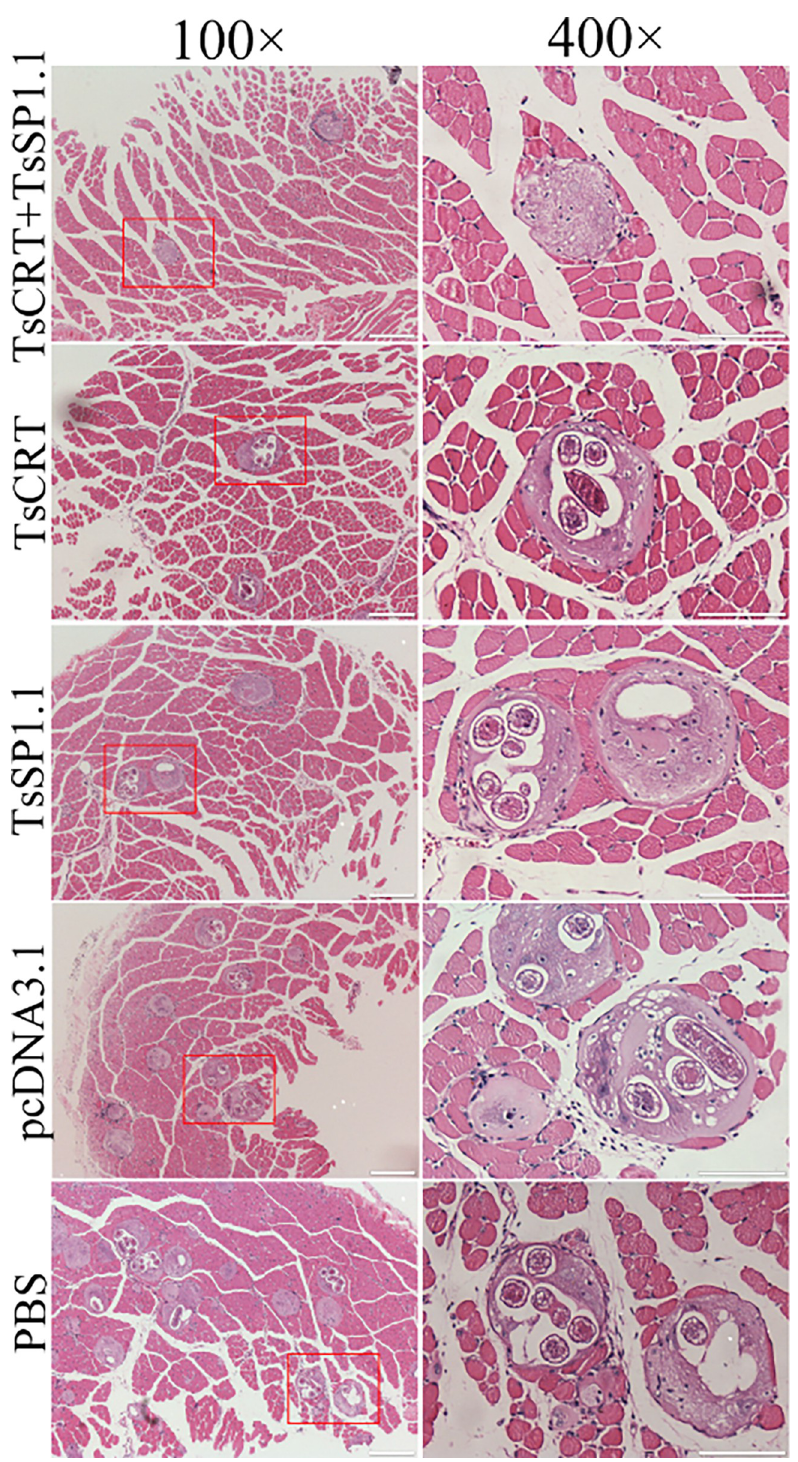
Fig 15. Muscle histopathological changes in immunized mice at 35 days after T . spiralis challenge. Mild inflammatory reaction and less encapsulated muscle larvae were observed in muscle section of three groups of mice immunized with TsCRT+TsSP1.1, TsCRT and TsSP1.1. Scale bars = 200 μ m.